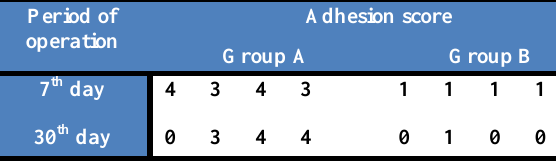
Table, 1: The adhesion scores according to macroscopic examination at 7 th and 30 th days post- operation for experimental groups. Period of Adhesion score operation Group A